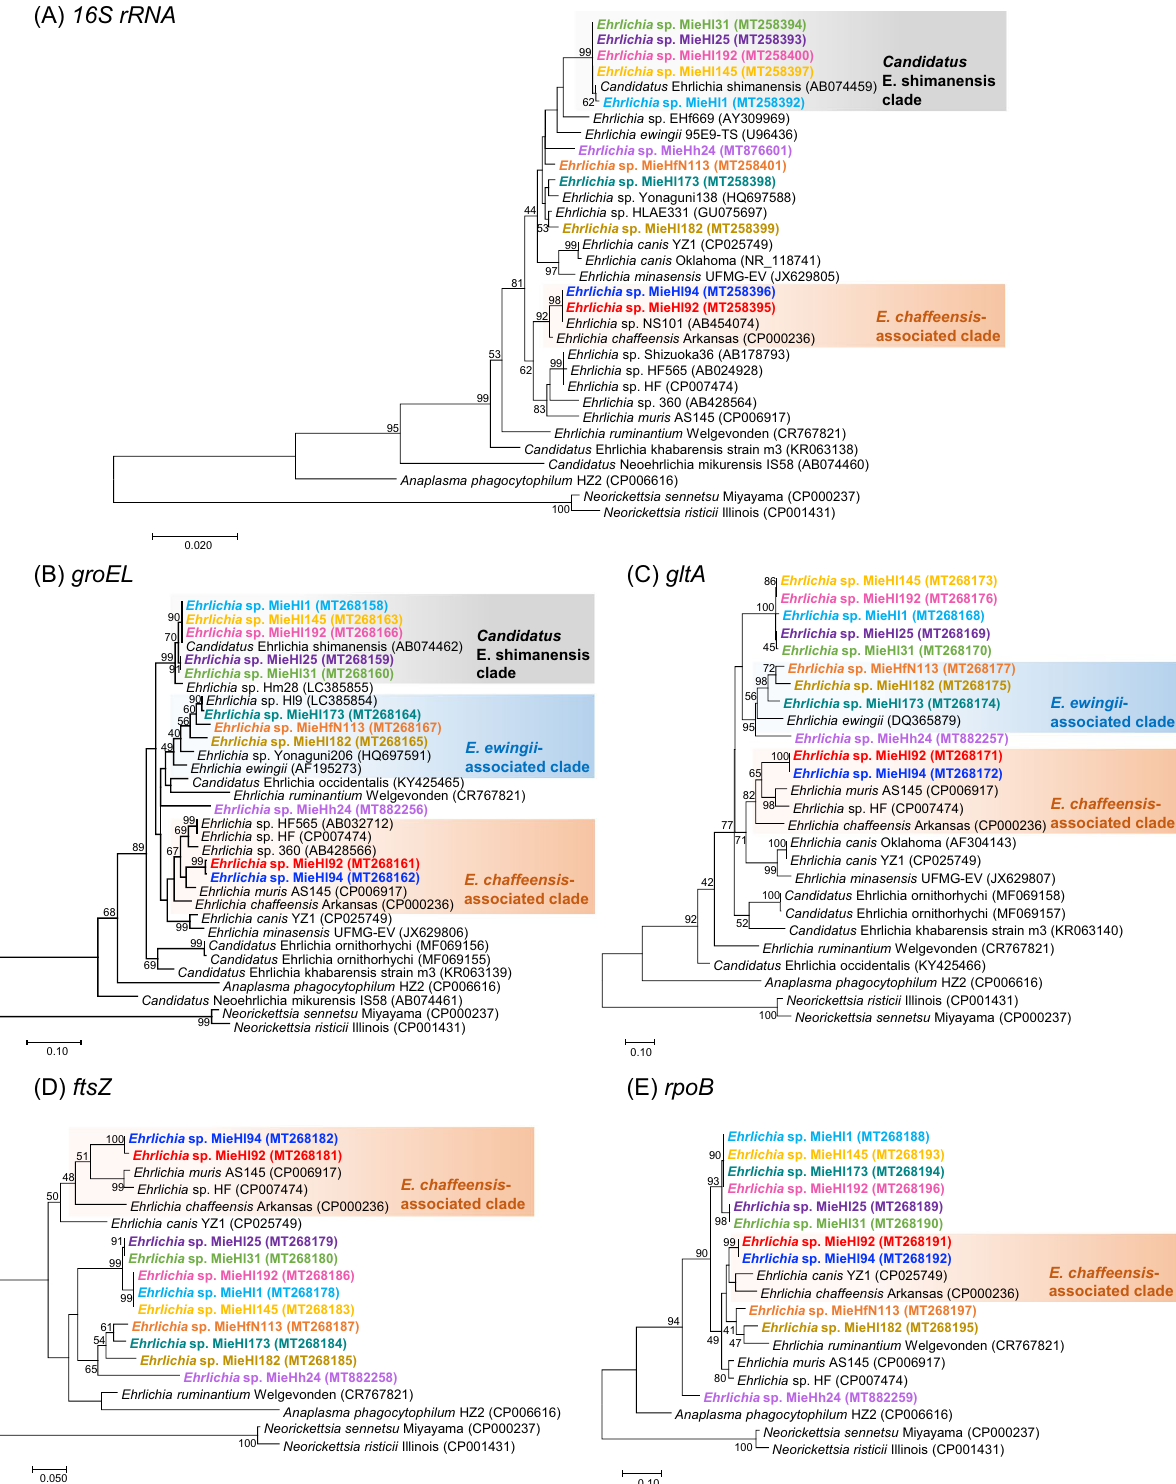
Figure 2. Phylogenetic analyses of five housekeeping genes from uncultured Ehrlichi a bacteria based on nucleotide sequences. ( A ) 16S rRNA (1396–1397 bp), ( B ) groEL (427 bp), ( C ) gltA (430 bp), ( D ) ftsZ (321 bp), and ( E ) rpoB (271 bp). These trees were constructed using the maximum likelihood method with the Kimura two-parameter model and “complete deletion” for gaps/missing data treatment. The bootstrap values were obtained from 1000 replications. Bootstrap values higher than 40 are shown in the tree branches. The scale bar indicates the evolutionary distance, and the accession number of each sequence is shown in parentheses. The uncultured Ehrlichia bacteria from tick individuals in this study are shown by characters with the same colors on the respective trees of five